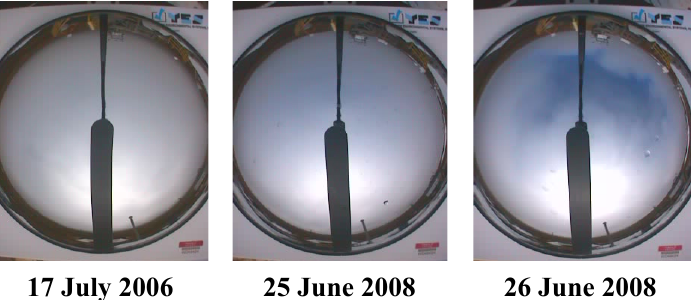
Figure 2. Total Sky Imager (TSI) images for selected three days 17 July 2006, 25 June 2008, and 26 June 2008 at local noon (23 UTC). Note that even at local noon, the Sun is near the horizon.